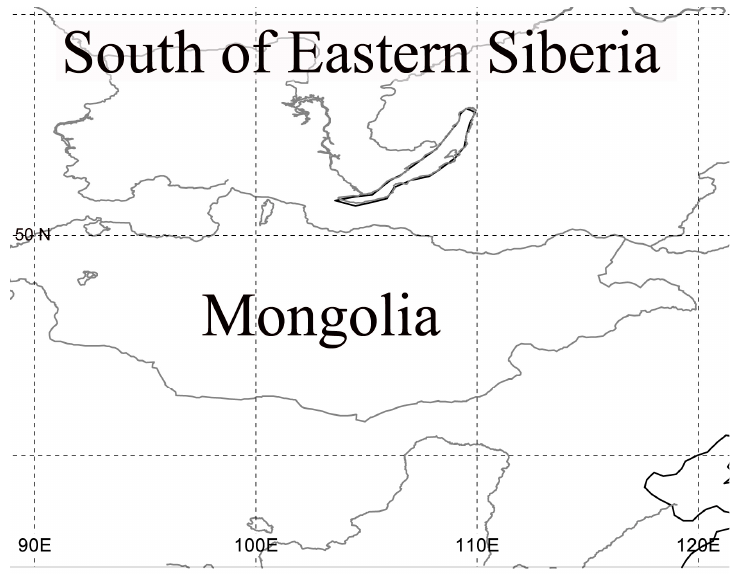
Figure 1. The map of the region under study.